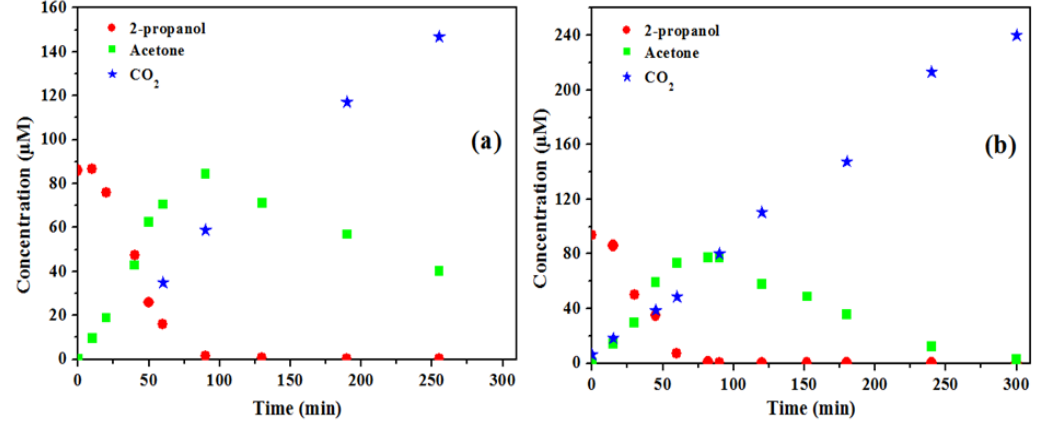
Figure 7. Photodegradation of 2-propanol and formation of acetone and CO 2 versus irradiation time in the presence of paper–TiO 2 ( a ) and paper–TiO 2 –AgBr ( b ).